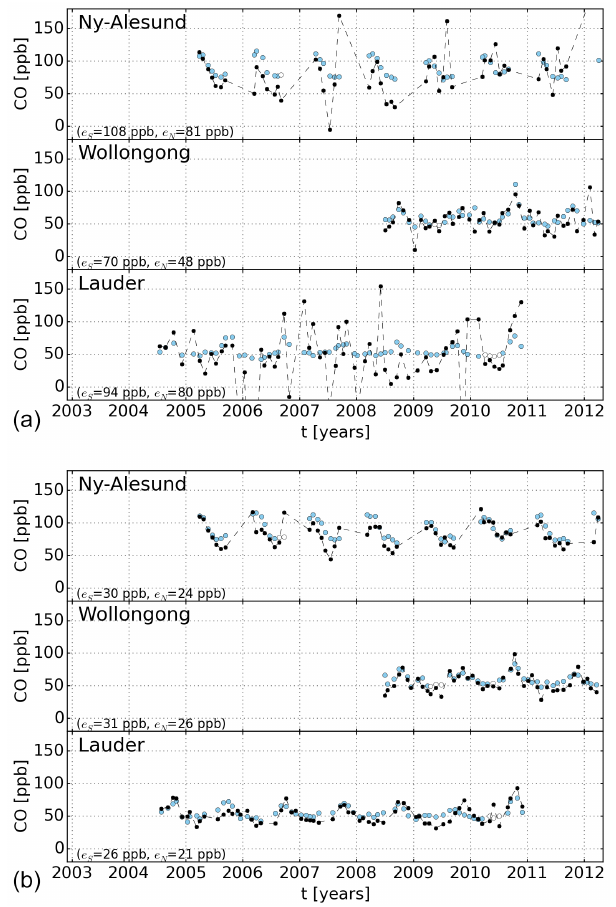
Figure 9. Same as Fig. 8, for TCCON measurements indicated in blue. For Wollongong and Lauder the GGG2014 release of TCCON was used. Except for Ny-Ålesund data, release GGG2012 is used because the newer release GGG2014 is not yet available for this site.